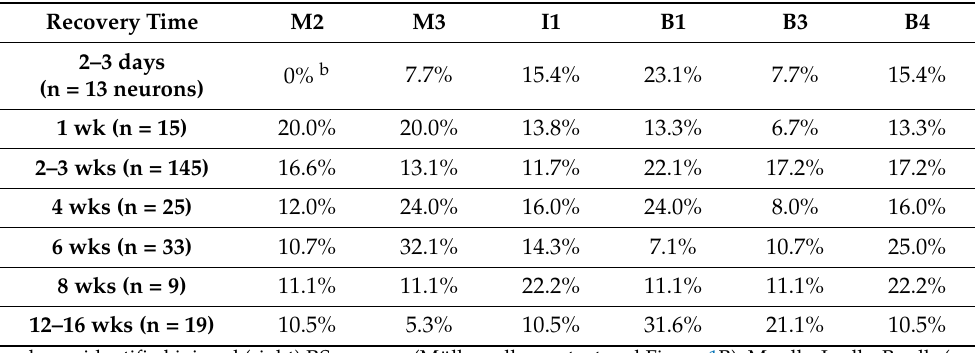
Table A1. Percentages of Different Injured RS Neurons a in Table 1 that were Recorded from at Different Recovery Times following Right Spinal Cord HTs at 10%